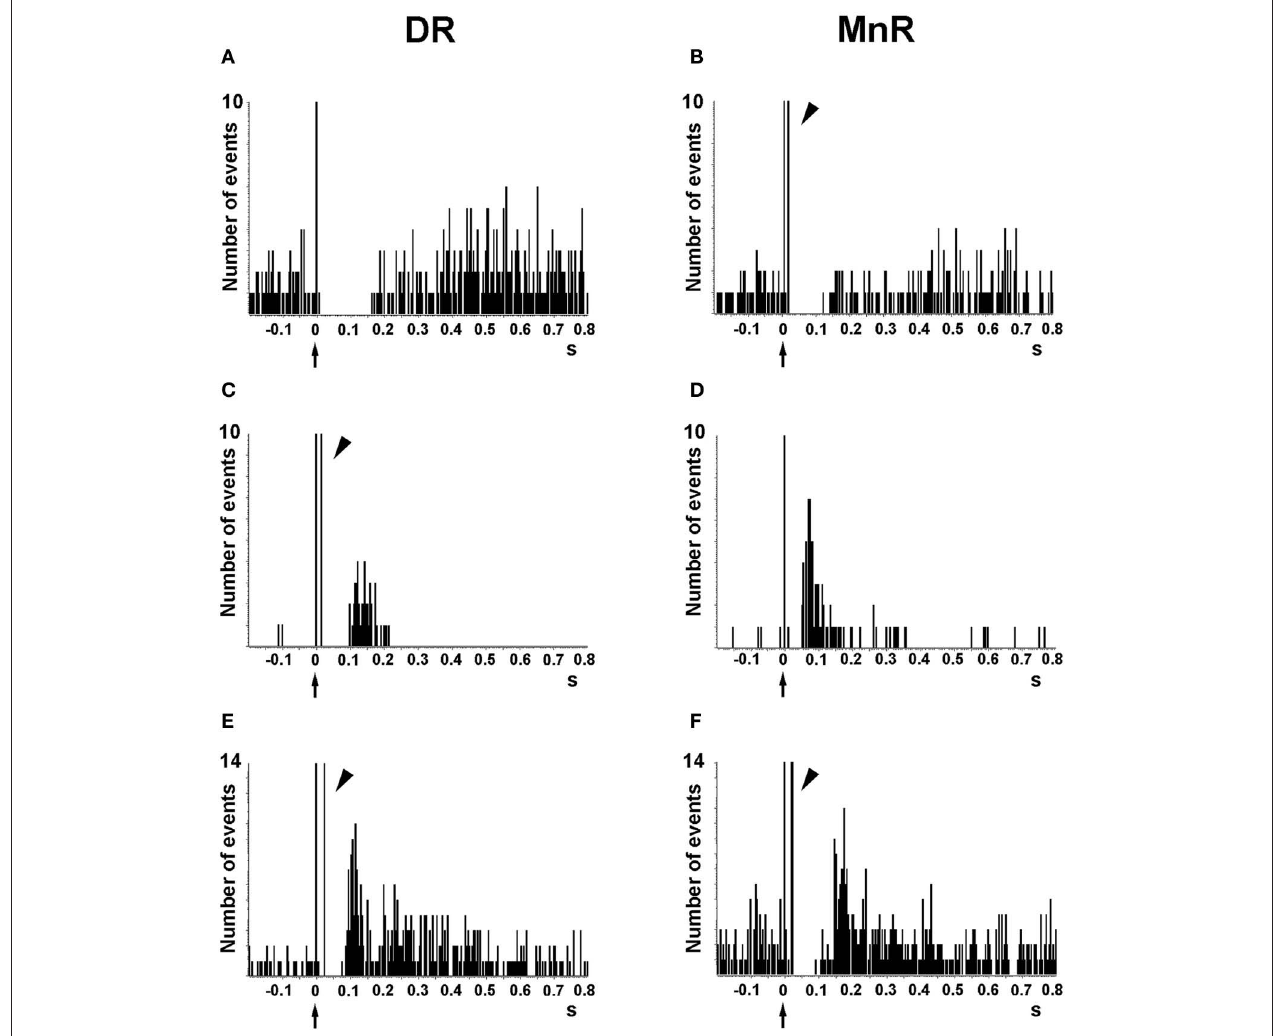
preceded by short latency inhibitions (biphasic responses). Note the presence of antidromic spikes in the units recorded (B,C,E,F) , resulting from the presence of a dense connectivity between the PFC and the DR/MnR. The units in (A) and (D) were antidromically activated at currents higher than those used to evoke a pyramidal response. Each peristimulus time histogram consists of 110 triggers (2min). Bin size = 4ms. The arrow in the abcissa denotes the stimulus artifact (time 0). The arrowheads indicate antidromic spikes. Reproduced with permission from Puig et al.